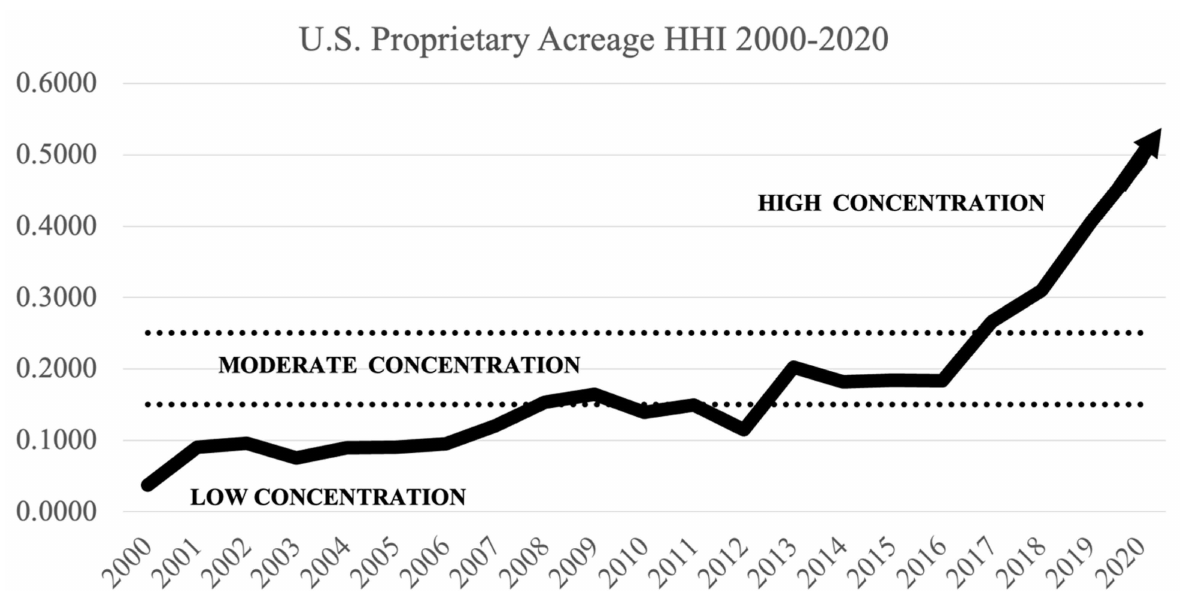
Figure 2. The HHI for total U.S. branded proprietary variety acreage 2000–2020 (own study based on